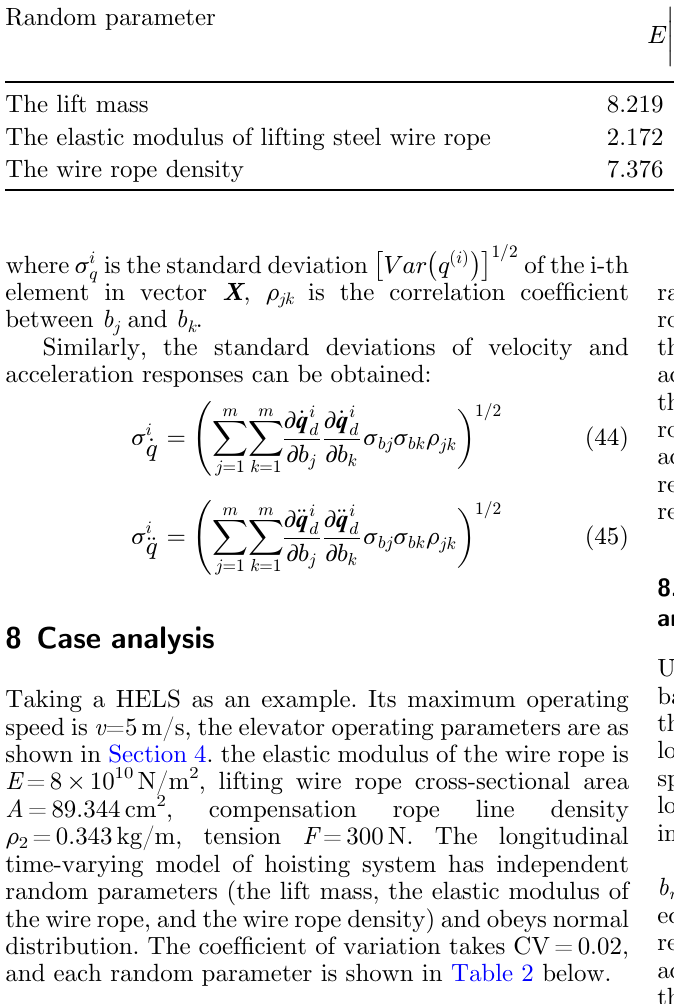
Table 3. Random parameter sensitivity mean. Random